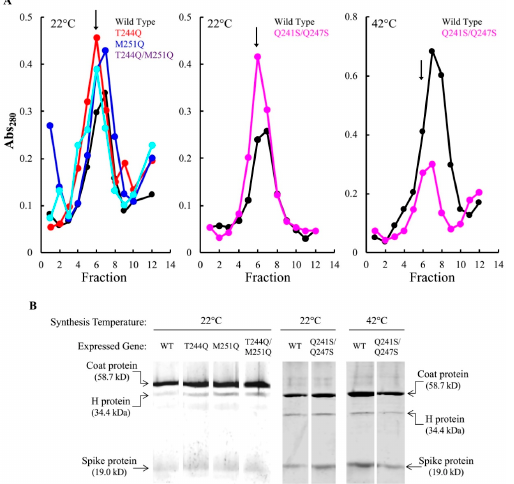
Figure 2. Assembled particles produced at restrictive conditions in mutant H expressing cells. ( A ) A 280 profiles of infected cell extracts analyzed by rate zonal sedimentation. Fraction 1 represents the gradient bottom. The fraction with the highest specific infectivity (pfu/A 280 ) is indicated with an arrow. Infection temperatures are indicated in the upper left of each graph. A color legend indicating the H gene allele resides in the upper right. ( B ) SDS-PAGE analysis of the fraction with the highest specific infectivity from panel ( A ). The white space between lanes indicates the removal of irrelevant lanes from the